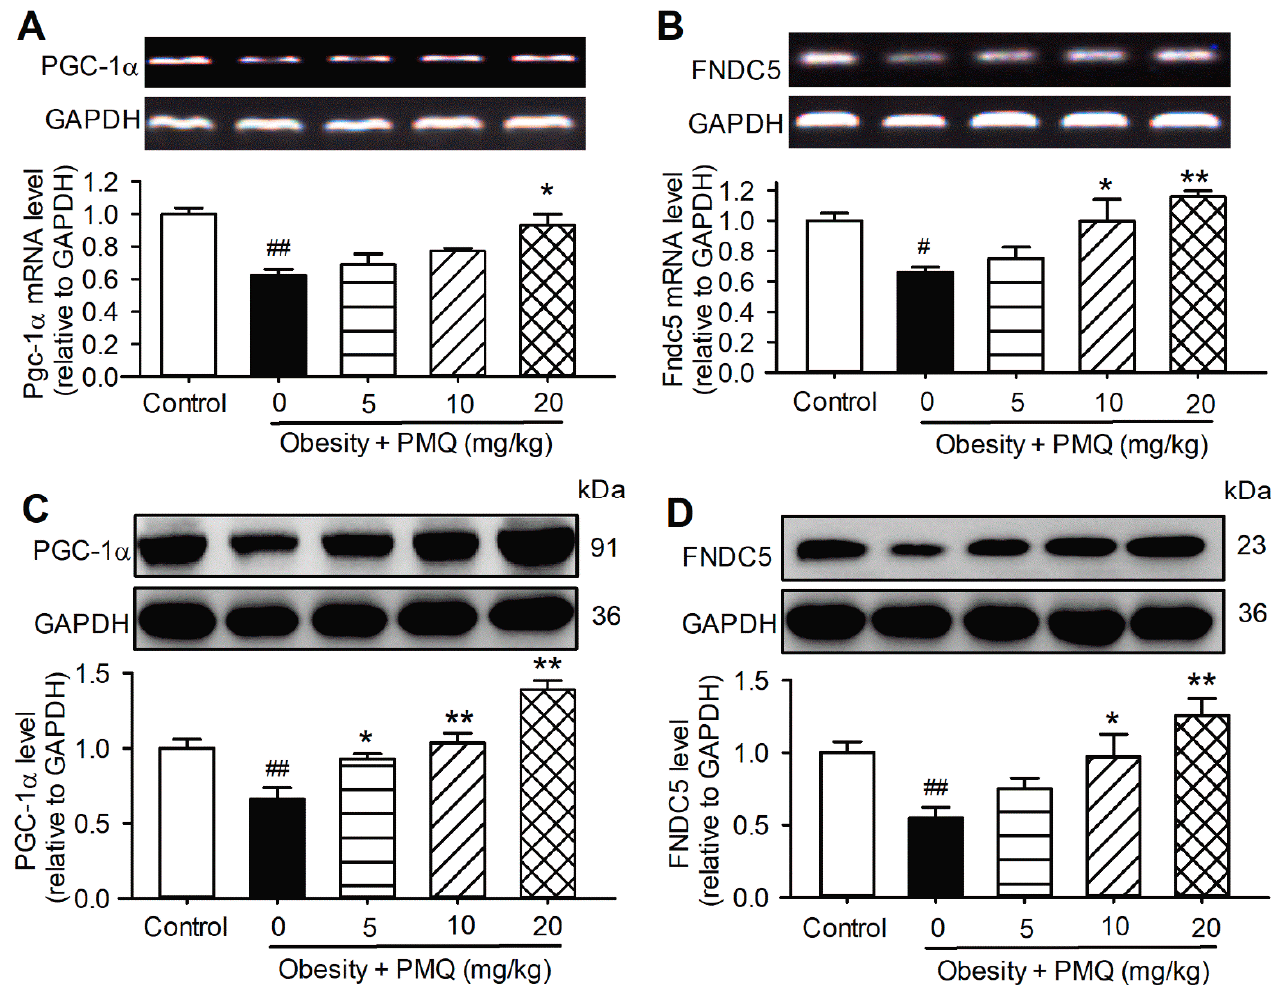
Figure 2. PMQ increases muscular PGC-1 α and FNDC5 expression level in mice. ( A , B ) Relative mRNA levels of Pgc-1 α and Fndc5 in gastrocnemius muscle of mice analyzed by RT-PCR. n = 3. ( C , D ) Protein levels of PGC-1 α and FNDC5 in gastrocnemius muscle of mice examined by western blot. n = 4. # p < 0.05, ## p < 0.01 vs. control group; * p < 0.05, ** p < 0.01 vs. obesity group. Data are expressed as means ± SEM.